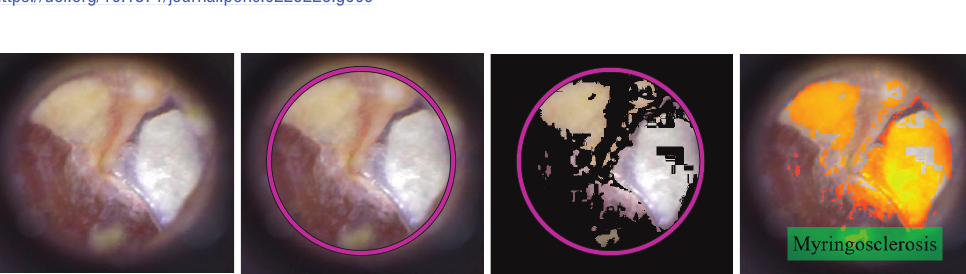
Fig 10. Myringosclerosis case: If the system classified the RGB input image as myringosclerosis condition, the system highlights the white areas found in the tympanic membrane. From left to right: RGB input image, region of interest, myringosclerosis segmentation and area under medical suspicion highlighted.